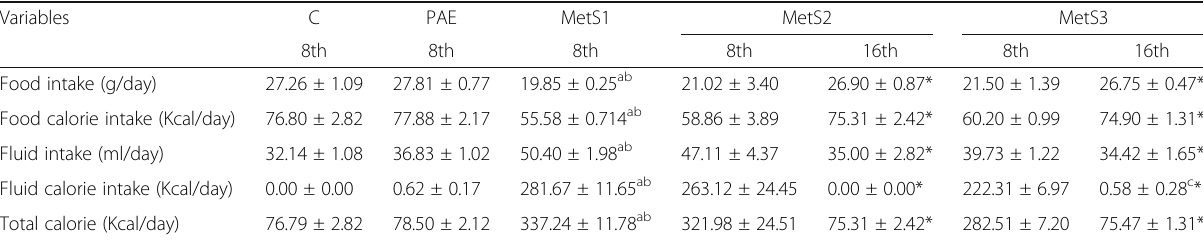
Table 1 Dietary Intake for C, PAE, MetS1, MetS2 and MetS3 at week 8 and 16